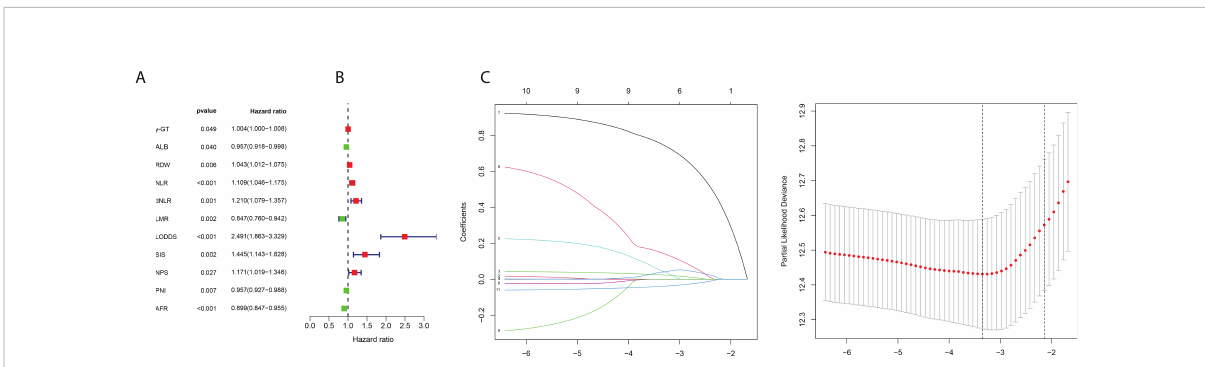
FIGURE 2 Filtering of variables. (A) Forest map of 11 prognosis-related variables based on univariate Cox regression. (B) LASSO coef fi cient pro fi les of candidate variables. (C) Ten-fold cross-validation results that identi fi ed optimal values of the penalty parameter l